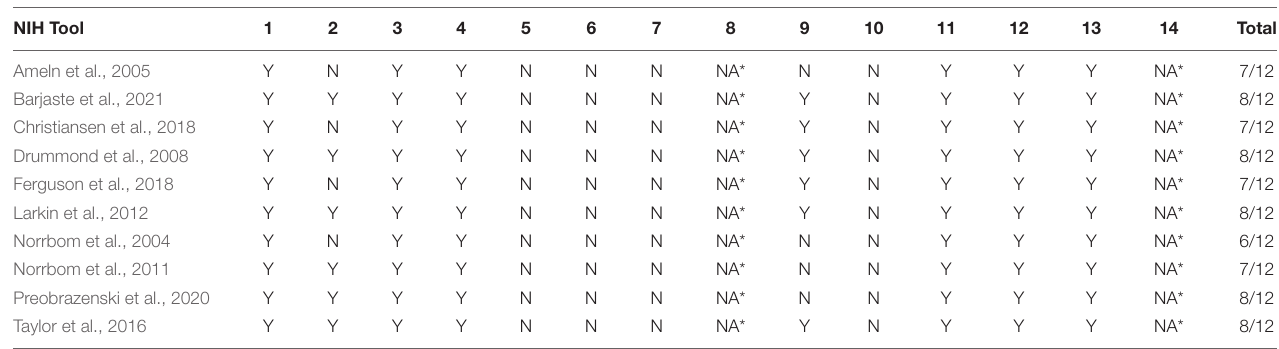
TABLE 2 | Depiction of the risk of bias